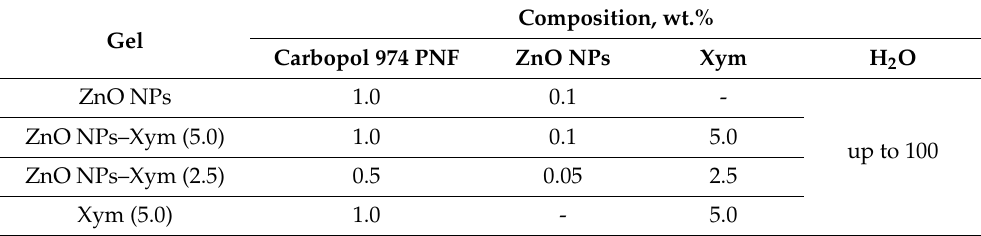
Table 1. Formulation of investigated gels. Composition, wt.% Gel Carbopol 974 PNF ZnO